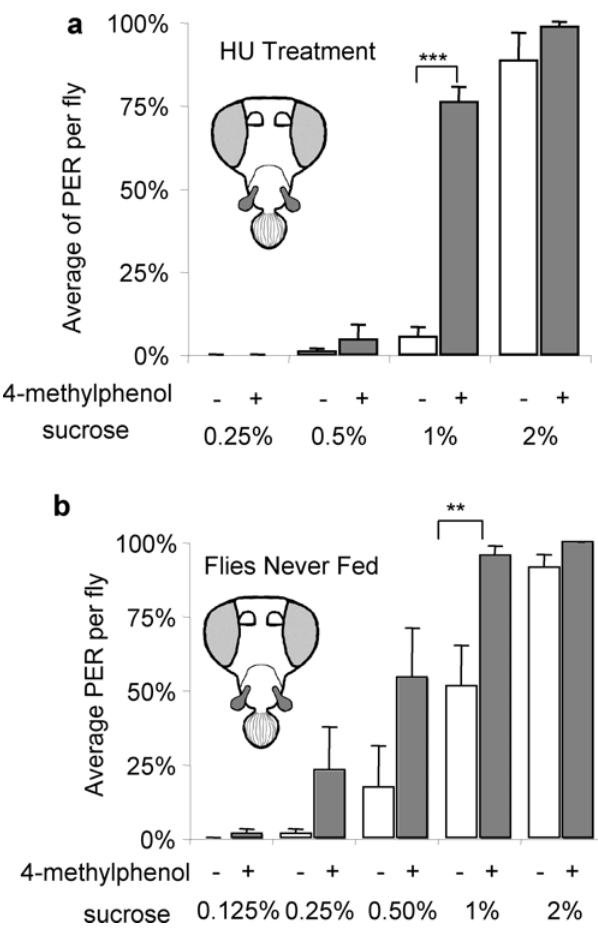
Figure 4. Effect of HU treatment on taste enhancement. Flies were treated with HU at early larval stage. a) Newly eclosed flies were collected before they can feed, and tested. b) Wild type Ant 2 , MP + flies were used. n=7 to